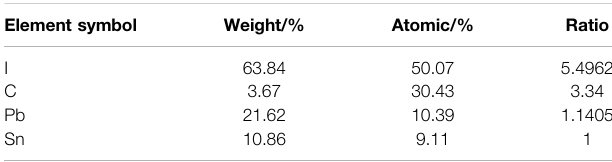
TABLE 1 | SEM – EDS results of element components and ratio of a